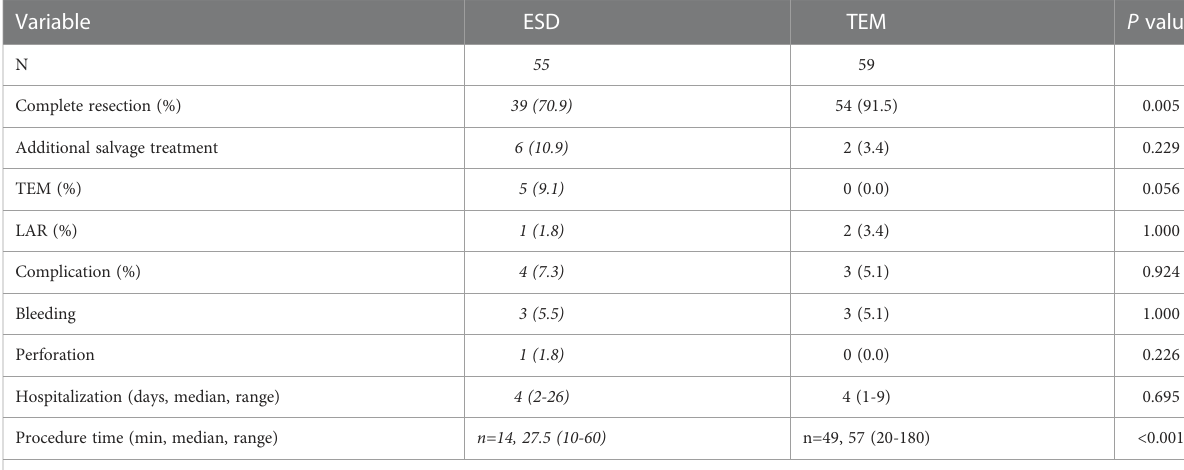
TABLE 2 Treatment outcomes for ESD and TEM